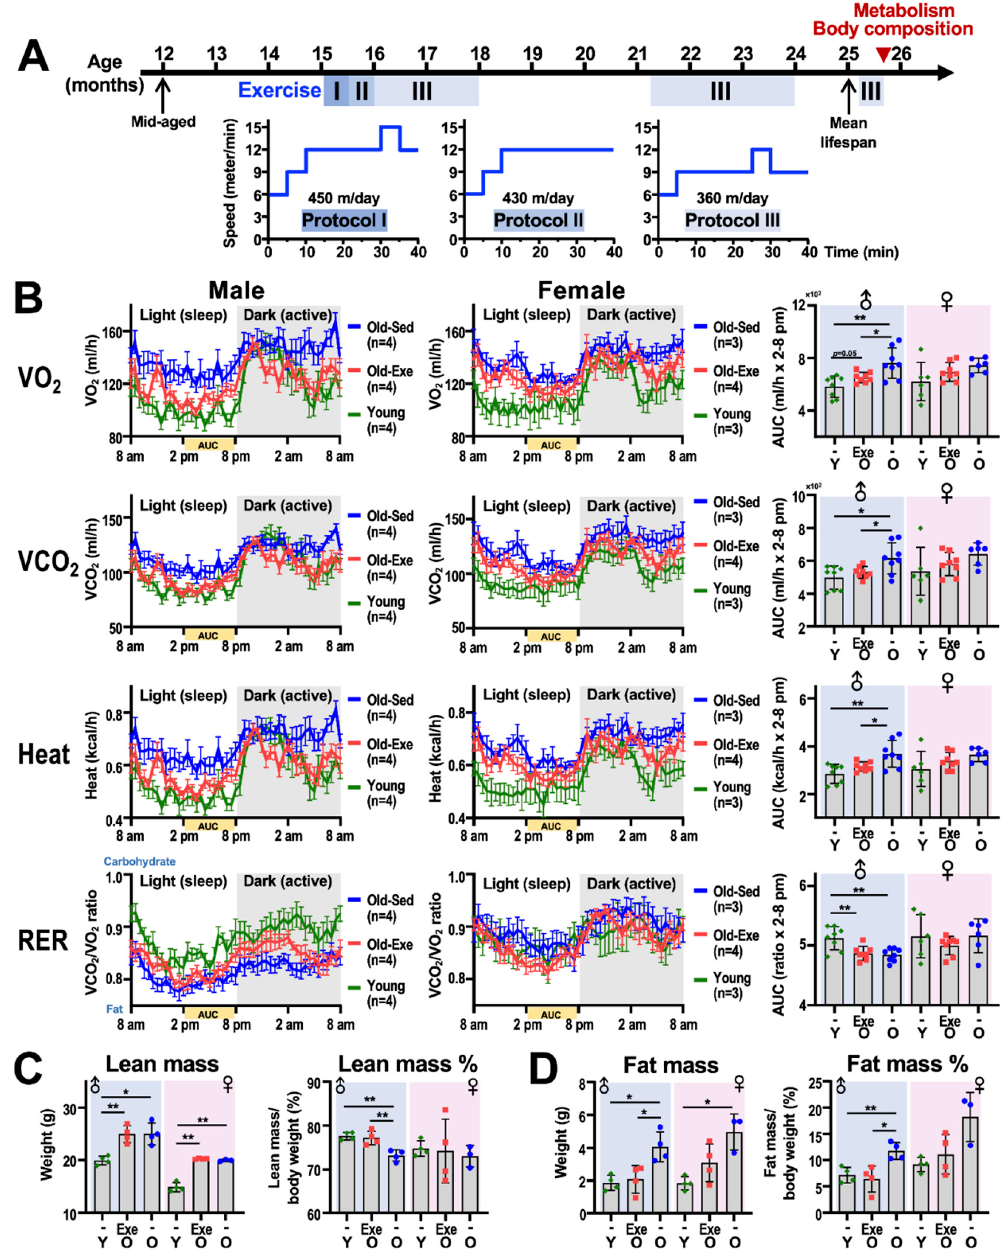
Figure 1. Systemic metabolism and body composition in mice during long-term exercise. ( A ) A schematic representation of the forced treadmill exercise protocol that was applied to mice when they reached 15-months of age. A ten-lane motorized rodent treadmill (SINGA Technology Corporation, Taipei, Taiwan) with 0 o of inclination was utilized for the exercise training. The exercise group of animals was trained on the treadmill; they ran 5 days/week for two 12-weeks cycles. In the first two weeks, the mice ran 450 m in 40 min per day. In the third and fourth week, the mice ran 430 m per